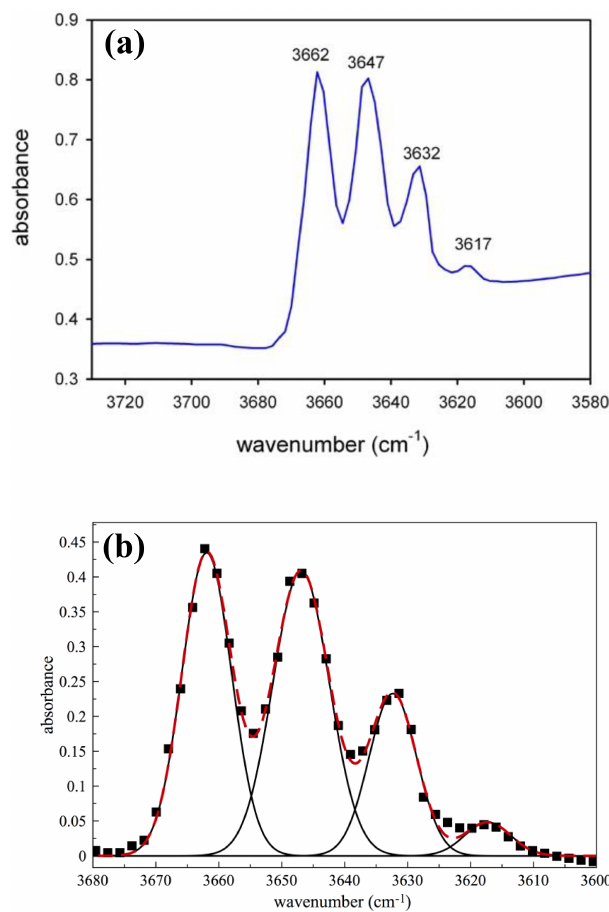
Figure 3. (a) Powder FTIR spectrum of the studied glaucophane in the OH-stretching region; (b) fitted spectrum. Squares: experimen- tal pattern; black lines: fitted components; dashed red line: calcu- lated spectrum.